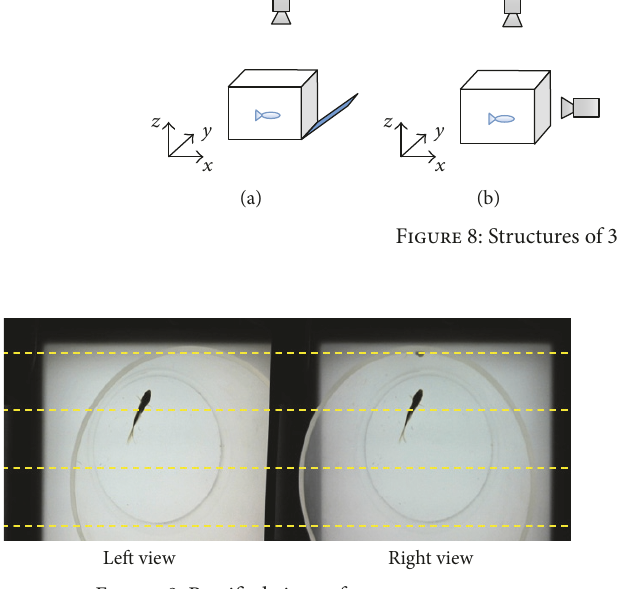
Figure 9: Rectified views of stereo